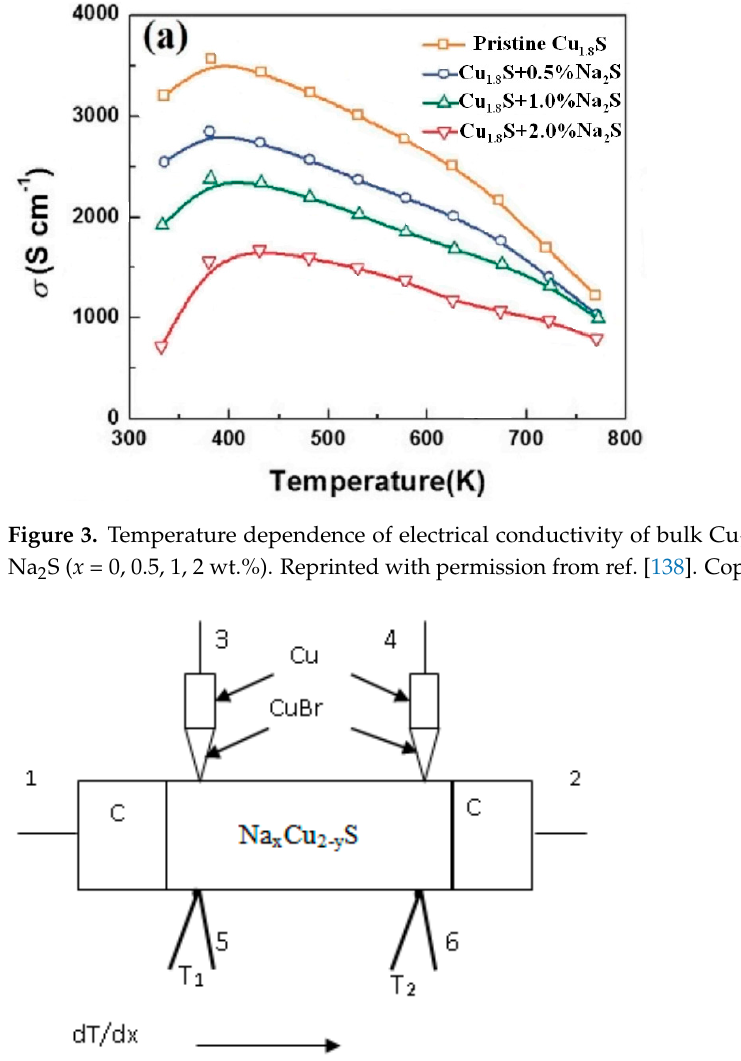
voltage drop across the electronic probes (Pt) when a direct current is passed through the electronic electrodes (Pt) [126]. When the current is switched on through the sample, the process of concentration polarization occurs in it, which is controlled by the chemical dif- fusion coefficient. For a 2 cm sample length, the equilibration time can range from a few